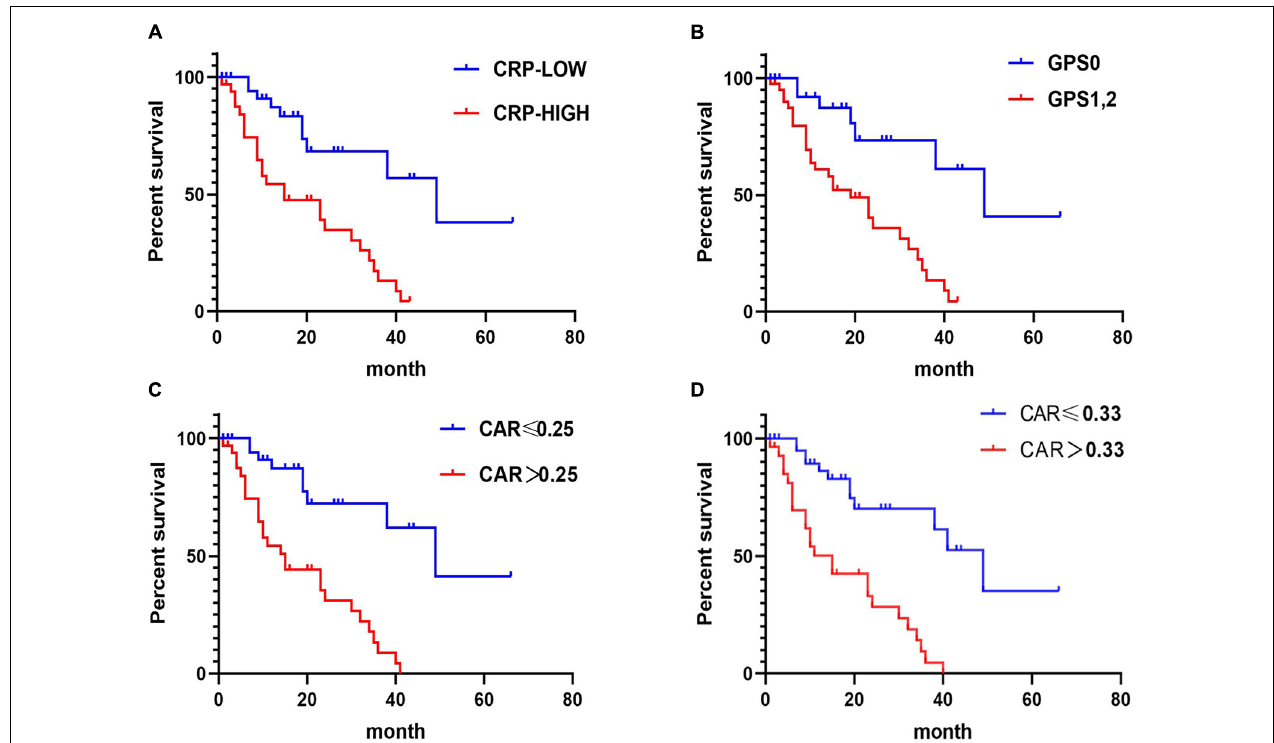
FIGURE 4 | Relationship between C-reactive protein (CRP), CRP-to-albumin ratio (CAR), and Glasgow Prognostic Score (GPS) and overall survival (OS) in patients receiving treatment for colorectal liver metastases (CRLM). (A) Relationship between the two CRP groups and OS. (B) Relationship between the two GPS groups and OS. (C) Relationship between the two CAR groups and OS. CAR was analyzed by grouping based on the cutoff value of the receiver operating characteristic (ROC) analysis in Figure 2C . (D) Relationship between the two CAR groups and OS. The optimal cutoff levels for CAR were produced using the X-tile plot in Supplementary Figure 1C